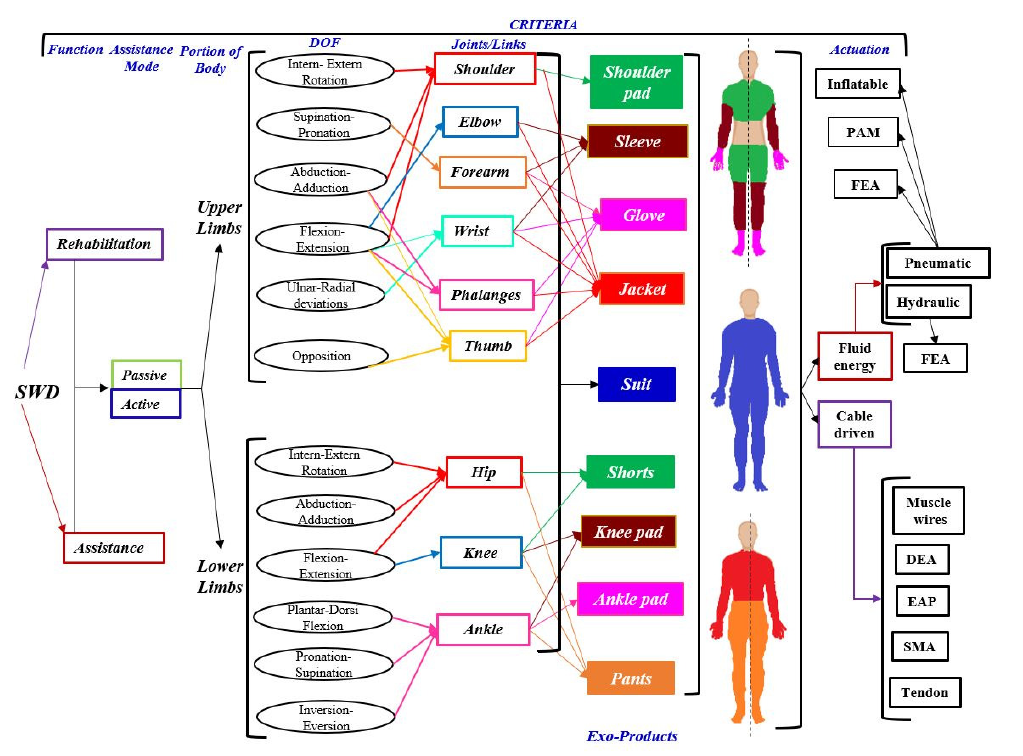
Figure 5. Modular platform for soft wearable